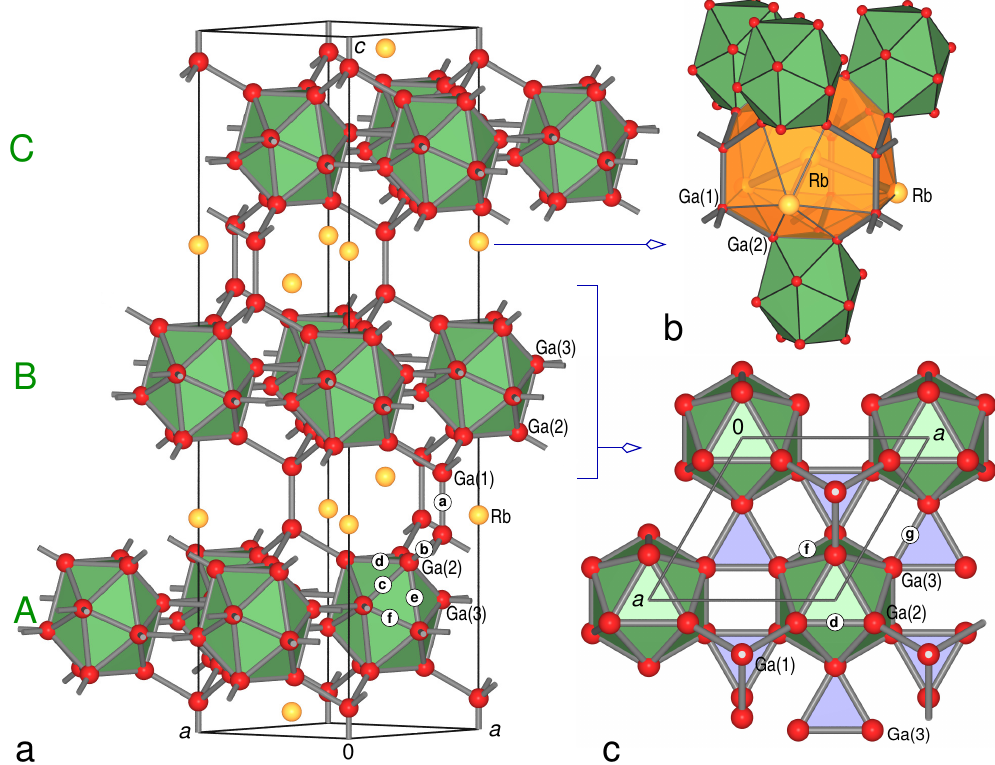
Figure 1. Crystal structure of RbGa : ( a ) Perspective view of the unit cell; ( b ) cation coordination 7 polyhedron (CCP) of Rb; ( c ) [001] projection of one icosahedra layer; (red spheres: Ga; yellow spheres: Rb; green polyhedra: [Ga ] icosahedra; yellow polyhedron: Rb + CCP (cf. Table 4 for bond labels and 12 interatomic distances of individual compounds; program D RAW XTL